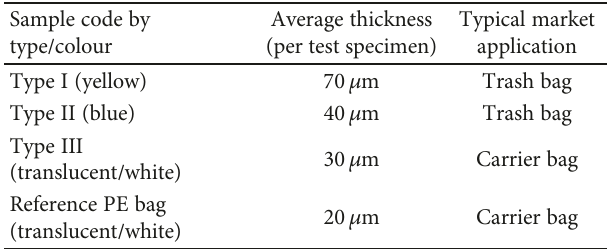
Table 1: Types and description of plastic bags considered for testing. Adapted from Al-Salem et al.